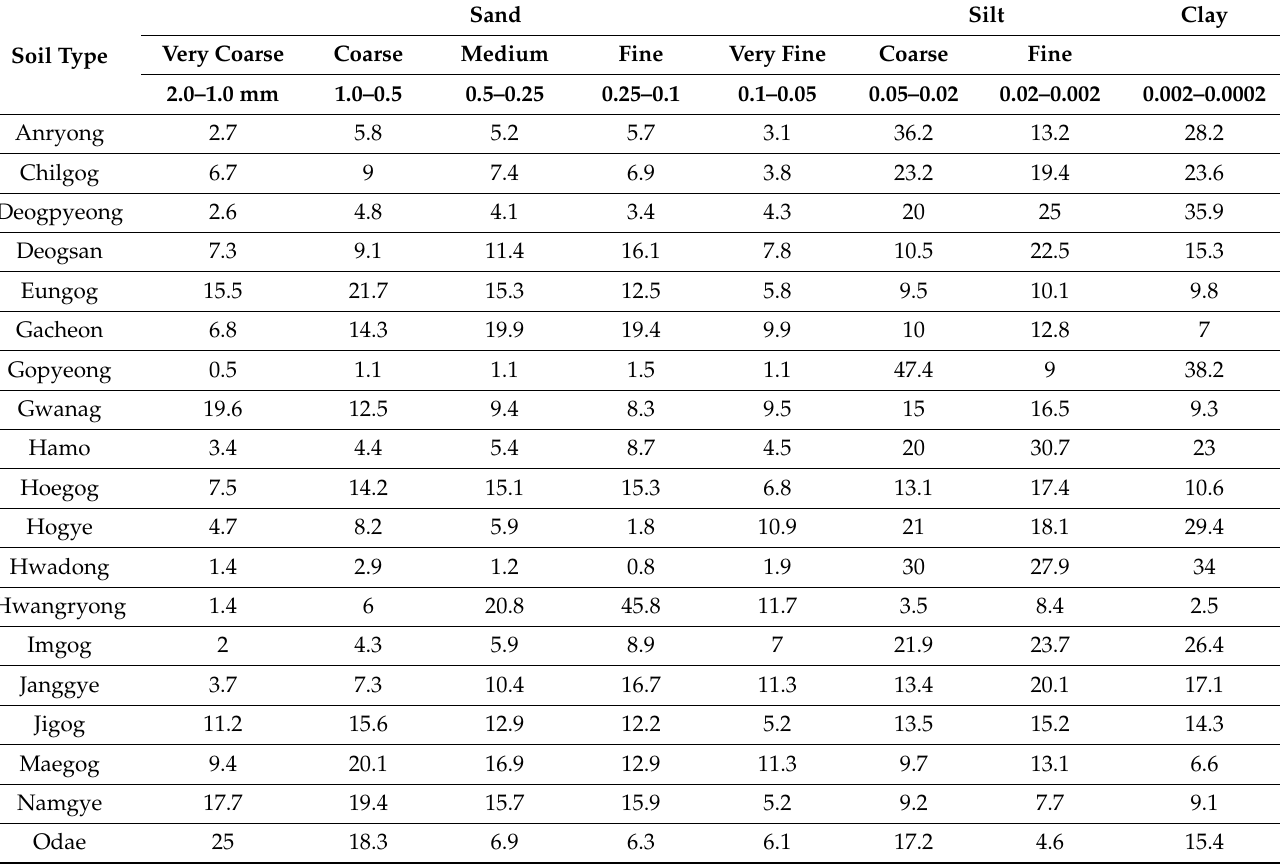
Table A2. Particle size distributions (%) in the Cheoncheon